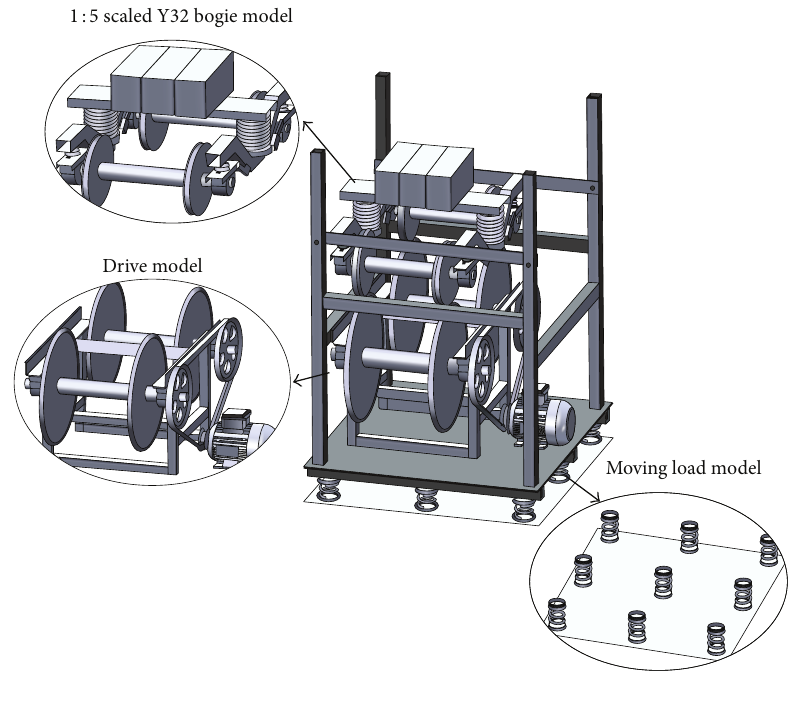
Figure 4: 3D CAD model of 1:5 scaled roller rig.